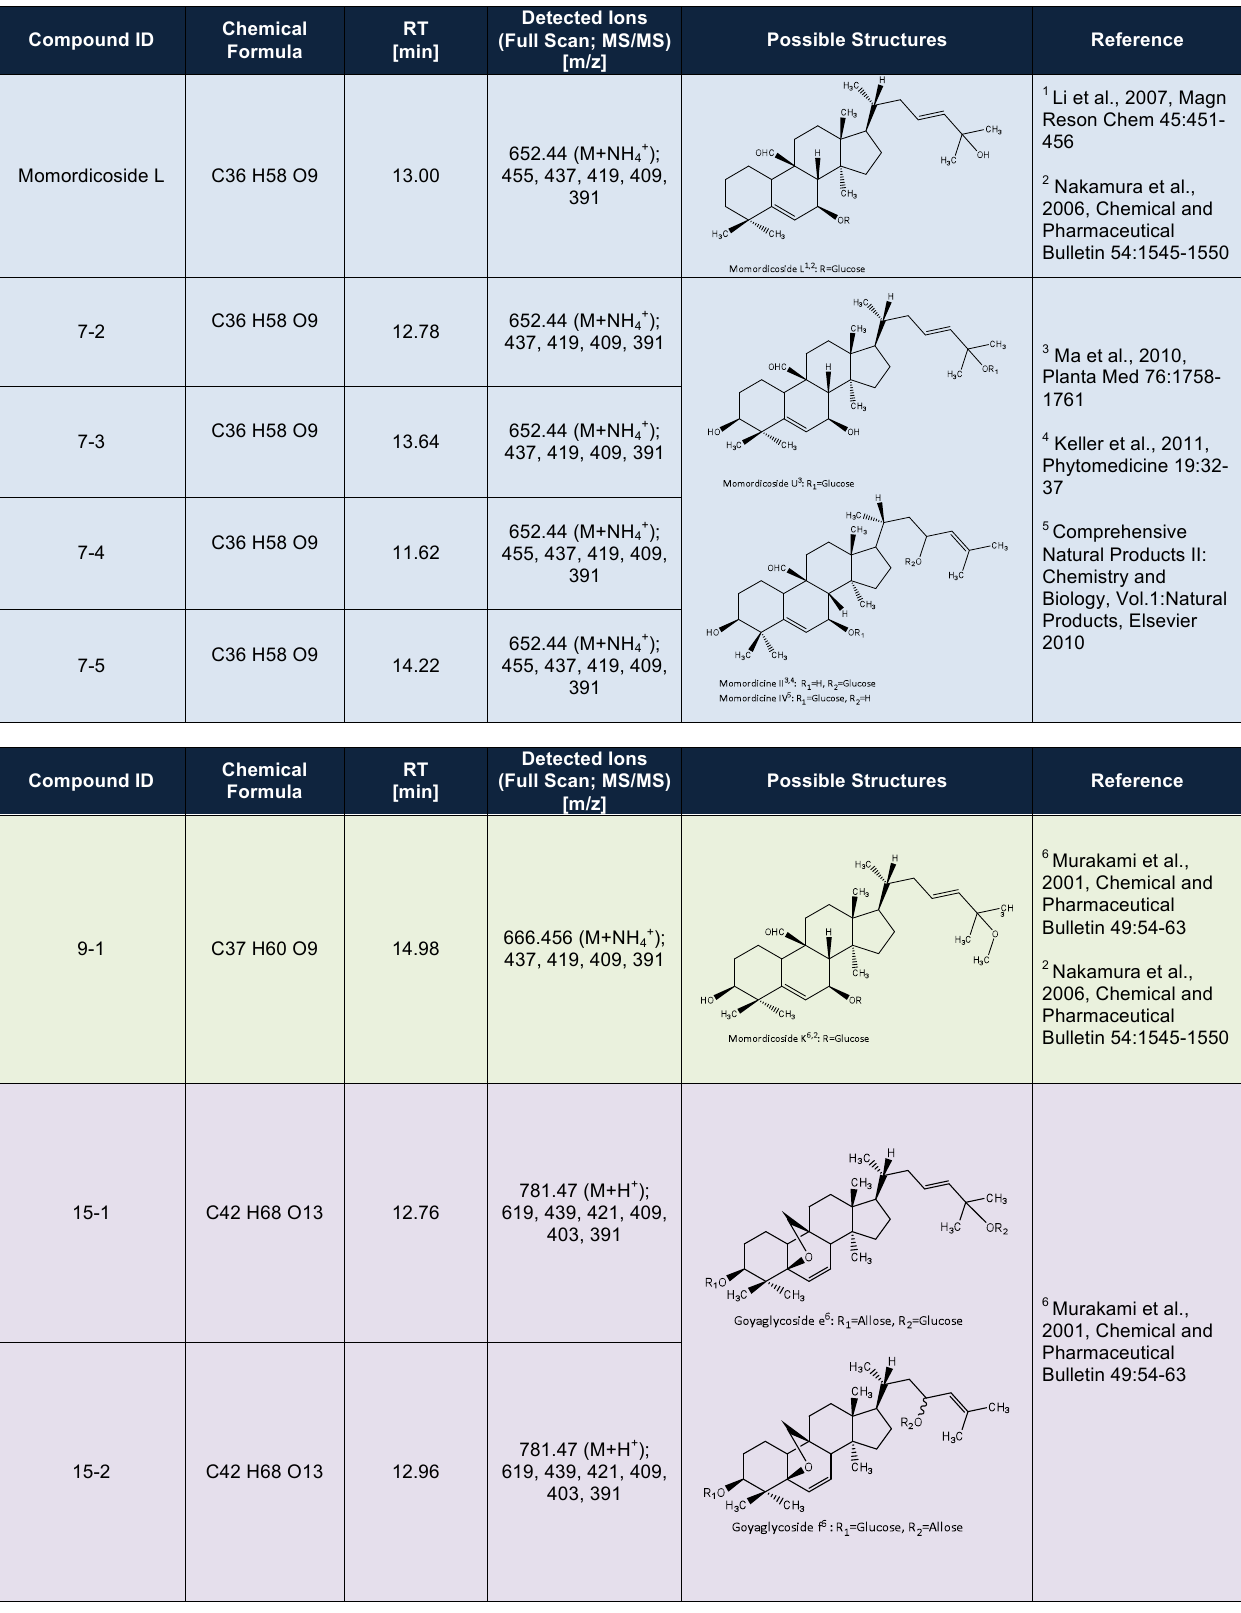
Table S1: Compound ID and the corresponding determined chemical formula based on LC-MS data (accurate mass, isotopic pattern) as well as possible structures of the measured bitter gourd saponins, derived from the LC-MS data (accurate mass, isotopic pattern, MS/MS) and literature. Furthermore retention time (RT) as well as detected ions (positive mode) in full scan and MS/MS are given. The same background color in the cells indicates the same chemical formula.